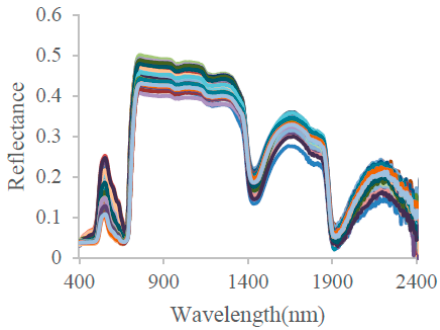
Figure 1. Fifty reflectance spectra of the leaves in the ANGERS dataset.